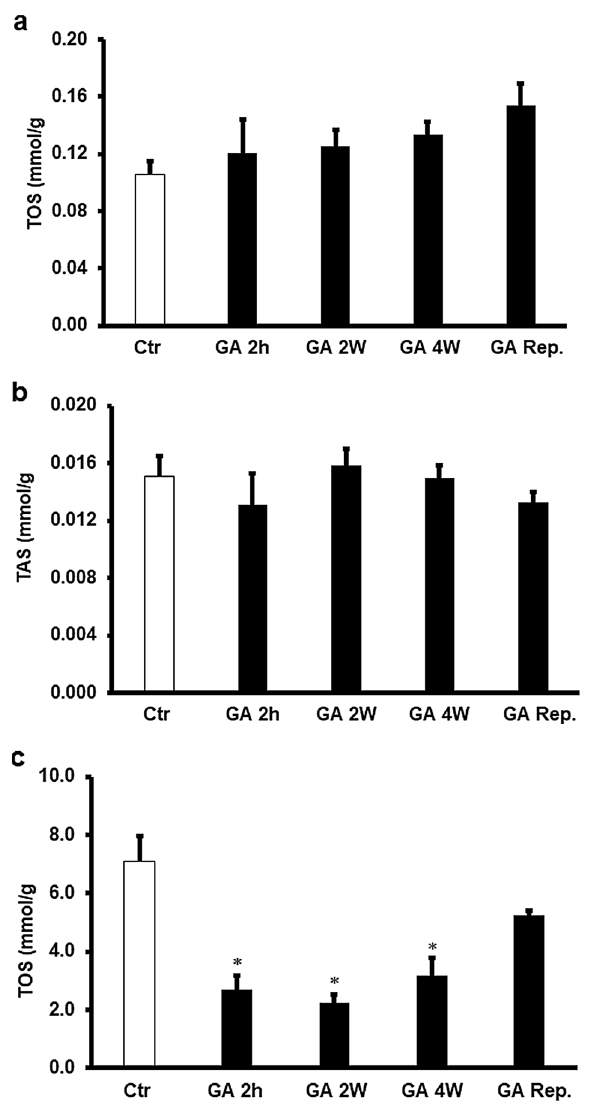
Figure 6. Estimation of oxidative stress in rat hearts. ( a ) Total oxidant and ( b ) total antioxidant levels in cardiac muscle samples after GA administration for 2 weeks, 4 weeks, or 2 h before sacrifice or at reperfusion compared to the levels in the control group (n = 4). ( c ) Total oxidants levels in the effluent samples after GA administration for 2 weeks, 4 weeks, or 2 h before sacrifice or at reperfusion compared to the levels in the control group. Ctr control, GA 2 h Gum Arabic infusion 2 h before sacrifice, GA 2 W Gum Arabic administration for 2 weeks, GA 4 W Gum Arabic administration for 4 weeks. *P < 0.01 compared to the respective